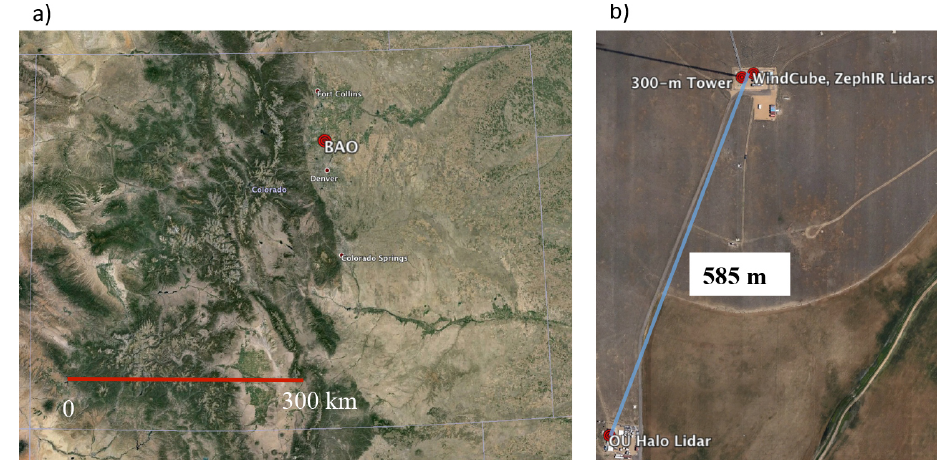
Figure 1. (a) Google Earth image of the state of Colorado. Location of BAO site is denoted by red marker. (b) Google Earth image of the BAO site. Instrument locations are denoted by red markers. Approximate distance between instruments is indicated by blue line and label. Only the initial location of the WindCube lidar is